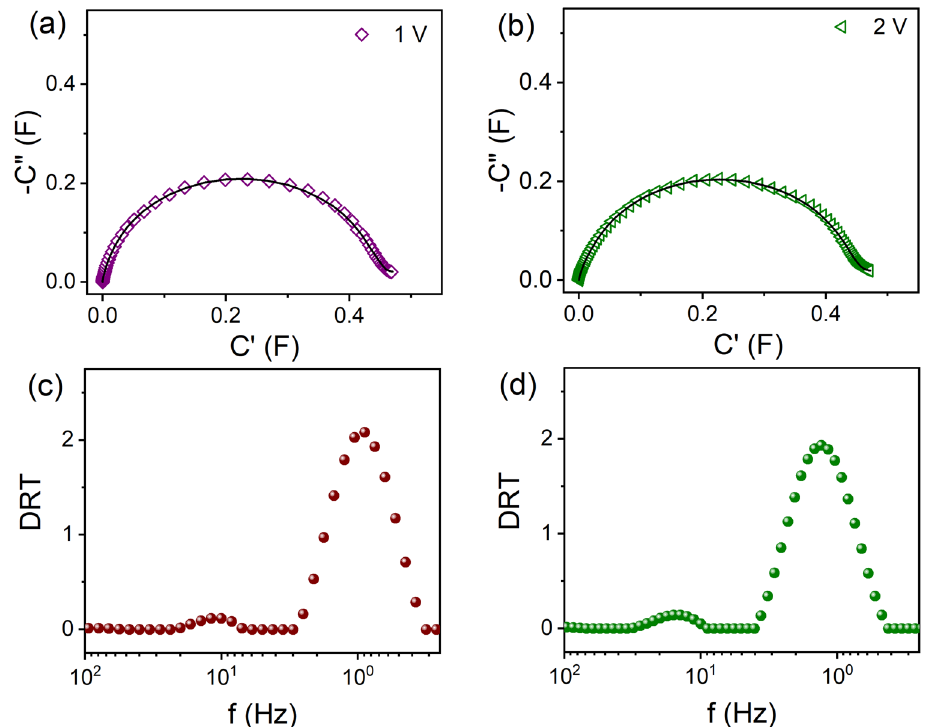
Figure 3. Nyquist plots of capacitances for supercapacitors at ( a ) 1 V and ( b ) 2 V dc bias voltages after 4000 cycles and corresponding DRTs are shown in ( c,d ) respectively. The solid lines in ( a,b ) are the fit using the code. The regularization parameter is set to